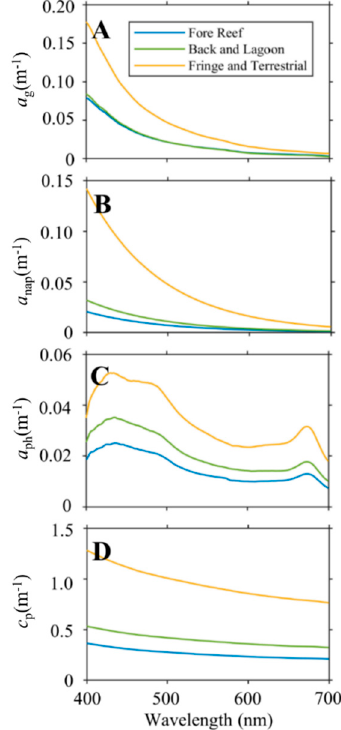
Figure 9. Mean spectra across geomorphic reef zones for absorption by CDOM ( A ), sediments ( B ), phytoplankton ( C ), and particulate attenuation ( D ).